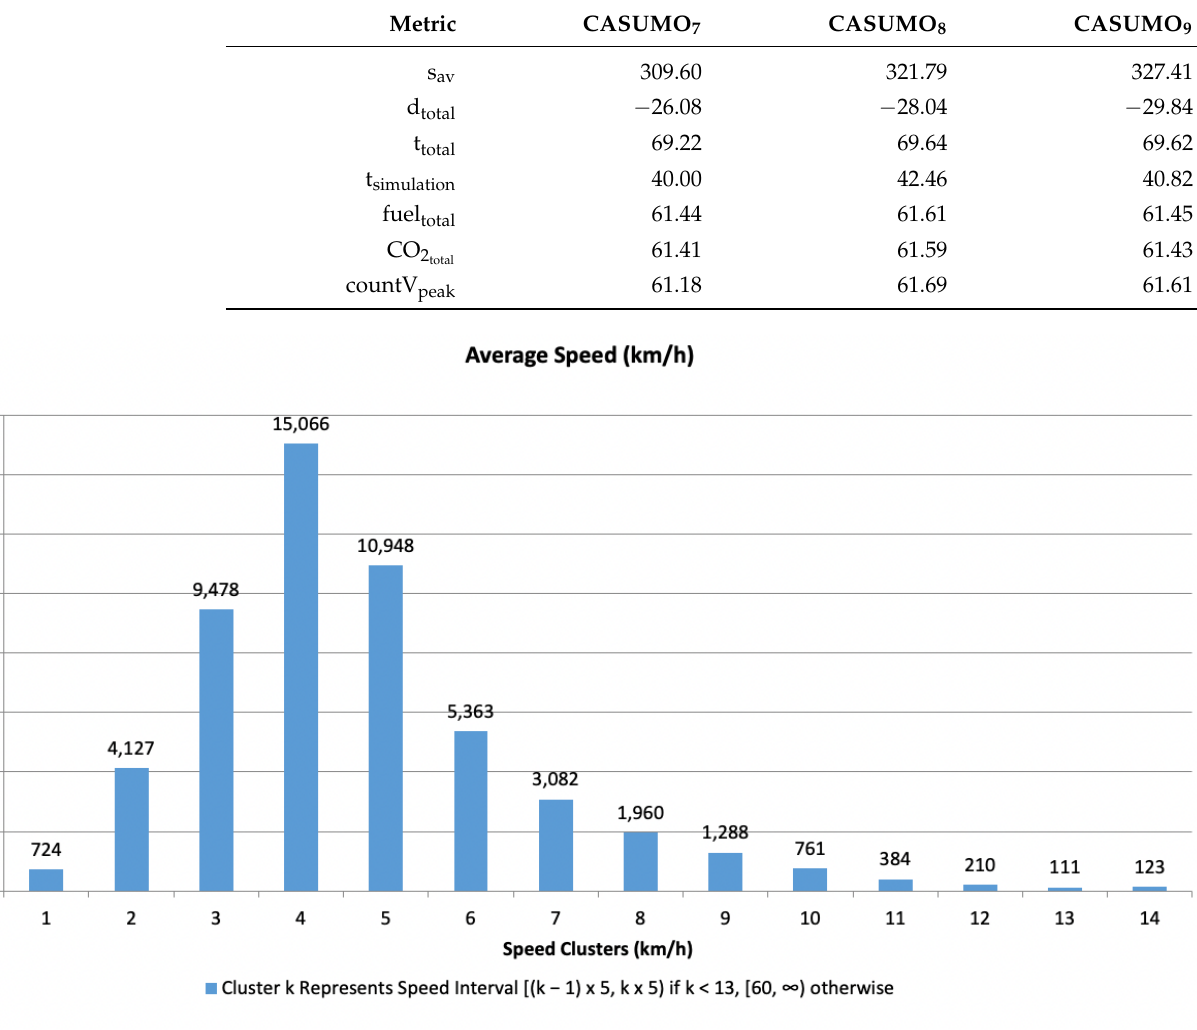
Table 9. Percentage improvement of the proposed solution for 50 K+ simulated vehicles in Tokyo.